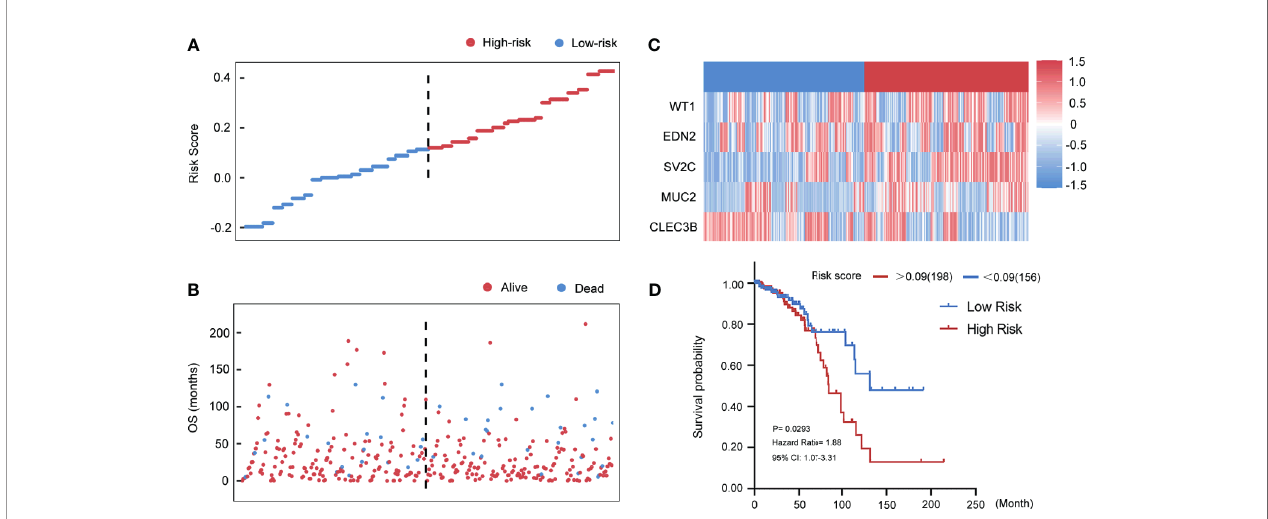
FIGURE 6 | Evaluating the predictive power of fi ve-gene signature in the training group. (A) Distribution of risk score. (B) Survival status of breast cancer patients in the training group. (C) Heatmap of the prognosis-associated gene expression pro fi les in the TCGA training cohort. (D) Kaplan ‐ Meier plot of the high ‐ and low ‐ risk groups in the training